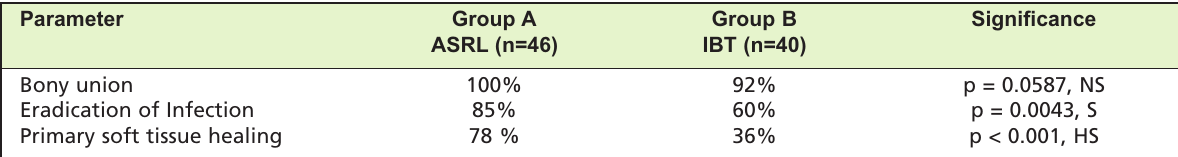
Comparison of results between ASRL and IBT Table III: